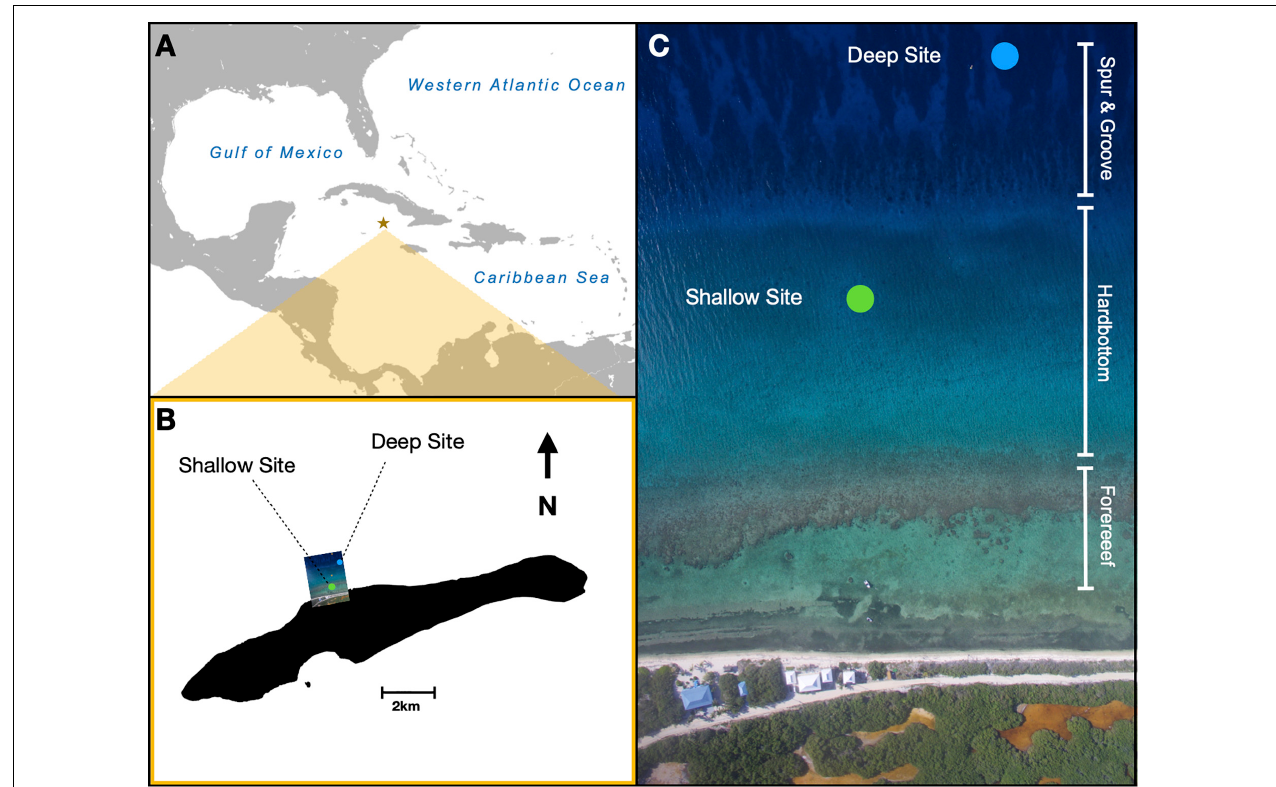
FIGURE 1 | Locations of nurseries for staghorn coral Acropora cervicornis examined in this study. Nursery sites were in the (A) central Caribbean on (B) the north side of Little Cayman Island. (C) Arial imagery shows the specific locations of the shallow (6–8 m) nursery site located in hardbottom habitat and deep (15–18 m) nursery site located on sand in between spur and groove